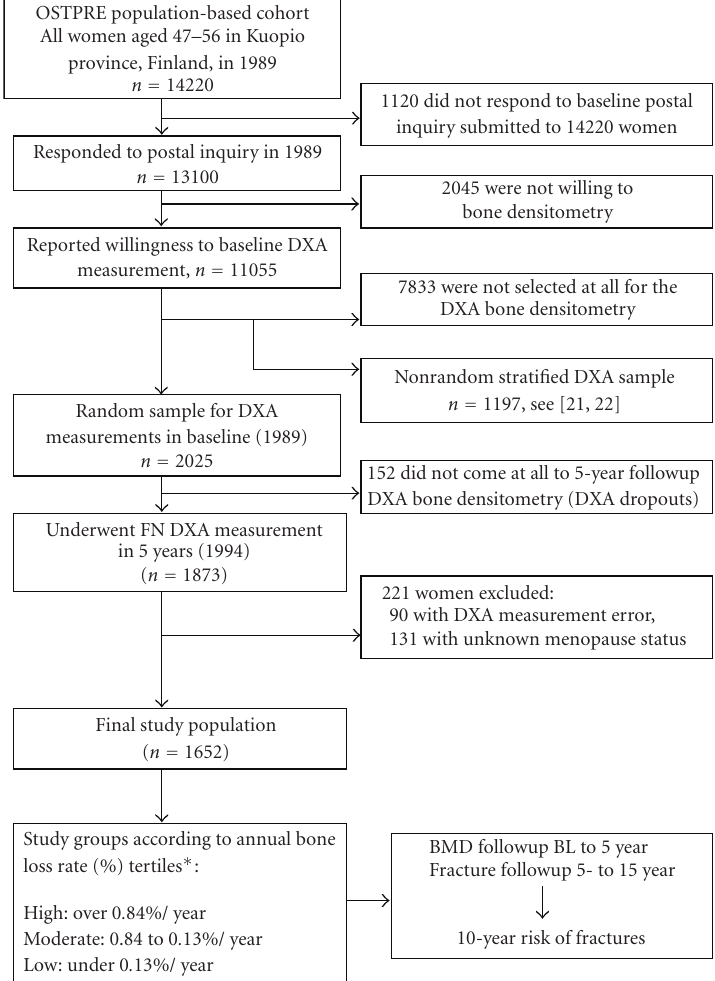
Figure 1: Study groups and study protocol ( n =